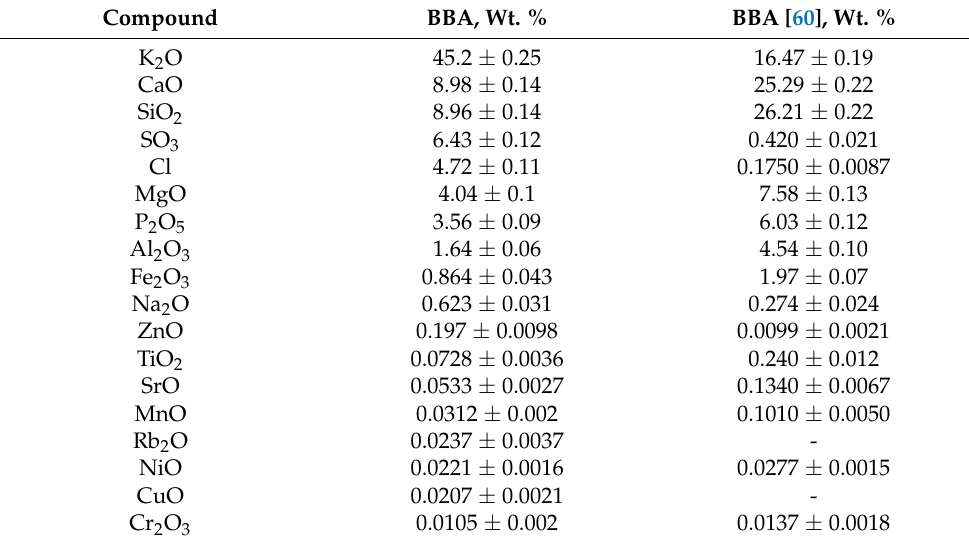
Table 5. X-ray fluorescence results of biomass bottom ash from this research and biomass bottom ash from the combustion of olive-pruning remains and vegetable-fat wastes [60].